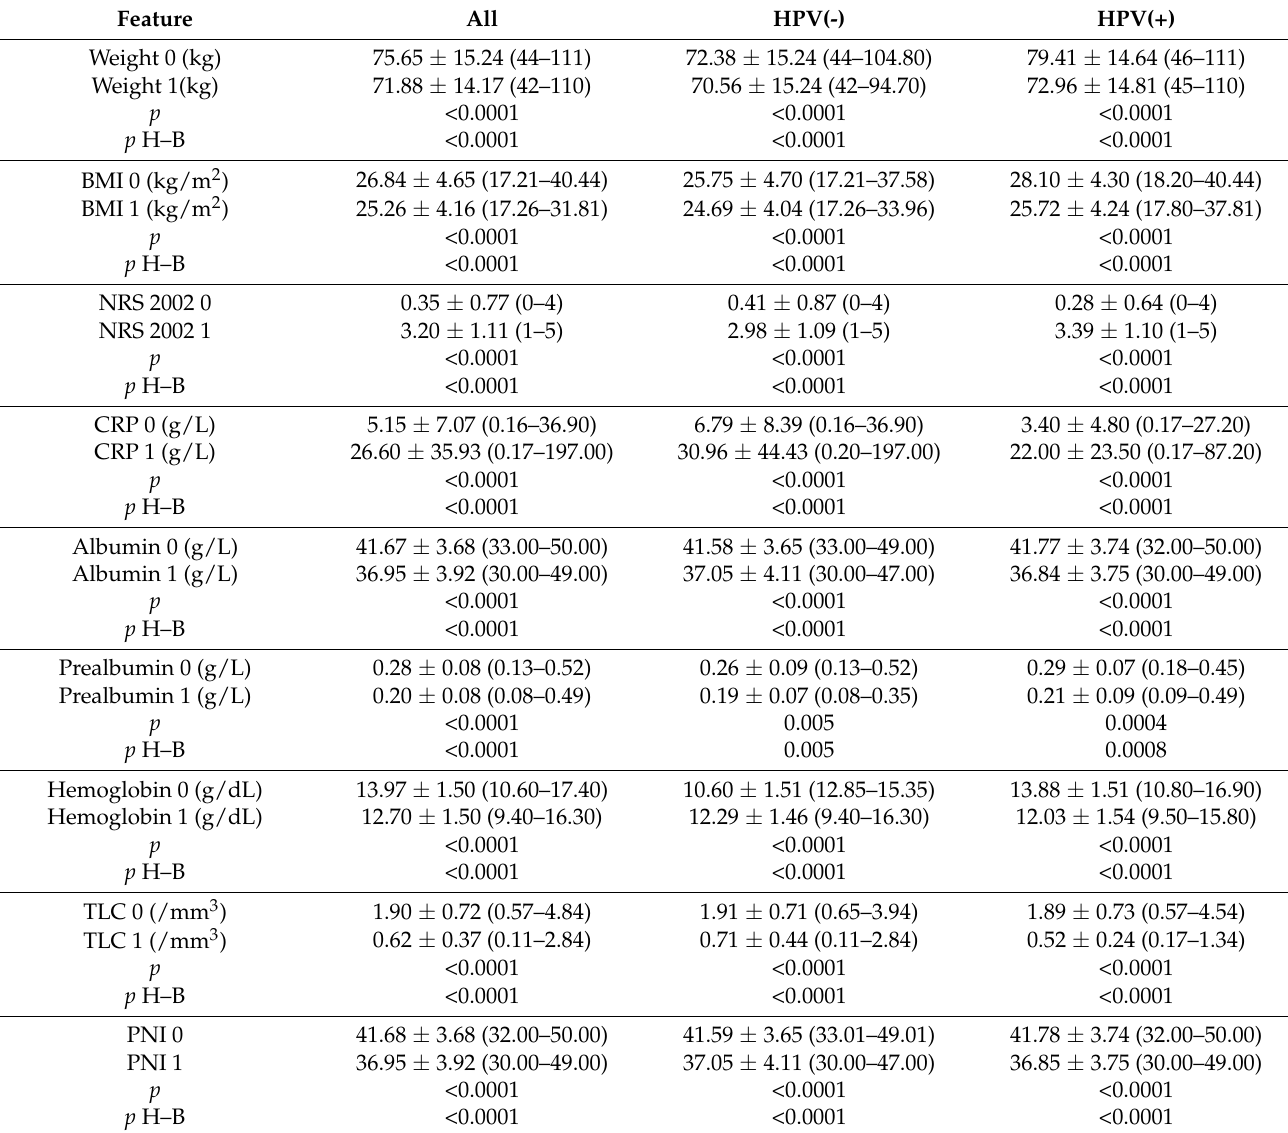
Table 4. BMI, NRS 2002, and laboratory results: differences before and after treatment in the HPV(-) and HPV(+) groups